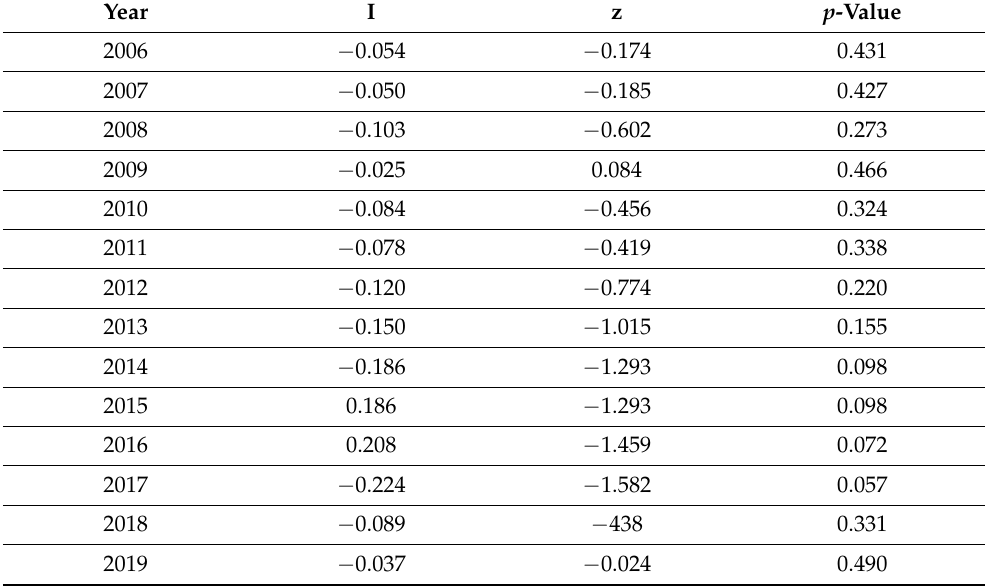
Table 2. Moran’s I index of tourism